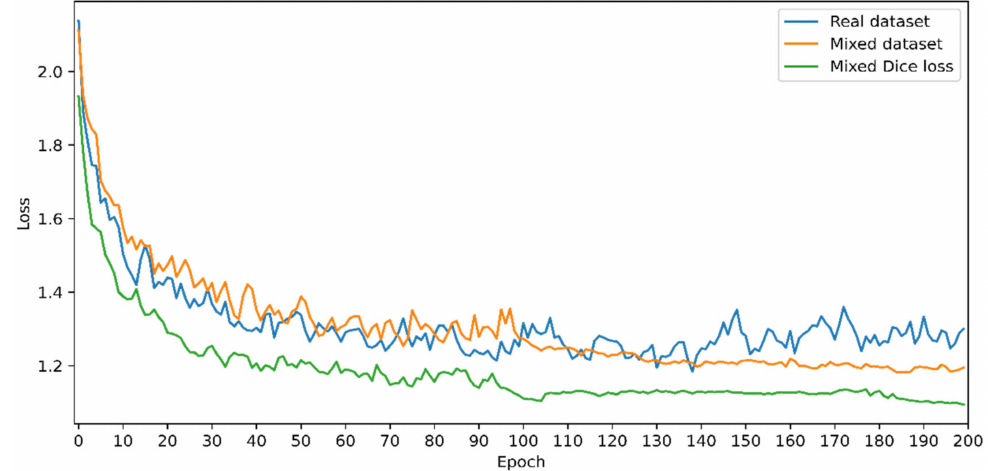
Figure 10. Dice loss